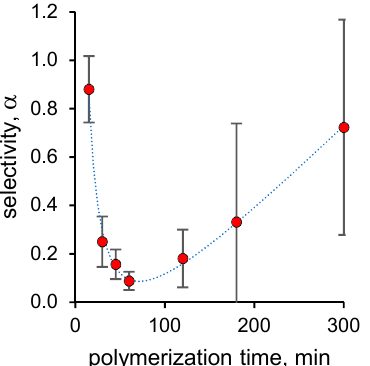
Figure 1. Binding selectivity of ciprofloxacin-imprinted nanoMIPs measured by comparing equilibrium binding constants for levofloxacin and ciprofloxacin. Error bars indicate 1 standard error unit.